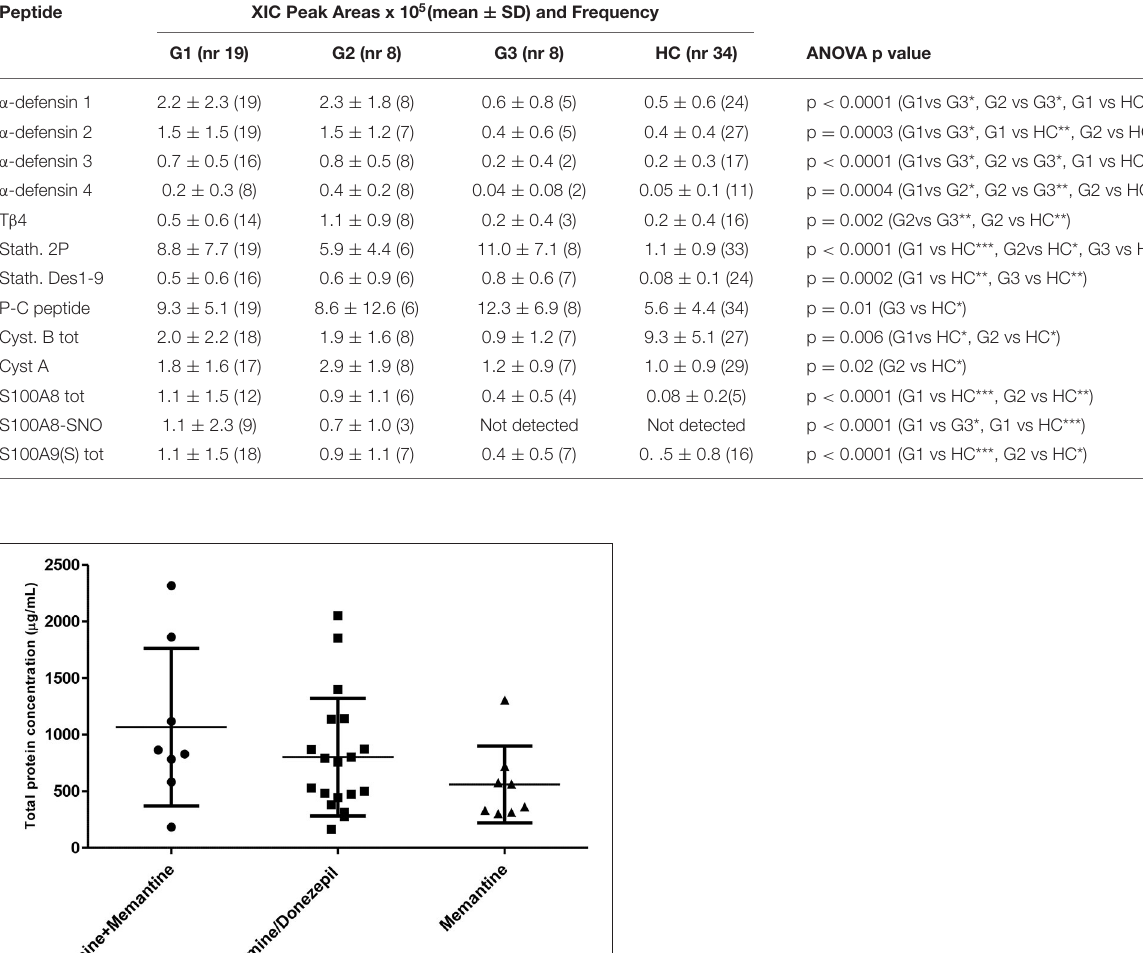
TABLE S4 | XIC peak areas values (mean ± SD) normalized on TPC, frequencies and p-values obtained by statistical analysis by comparing the three patients’ groups treated with different therapies by non-parametric ANOVA with the Krustal-Wallis test and Dunn’s post test. p-values > 0.05 are not statistically significant ( • ). Peptide